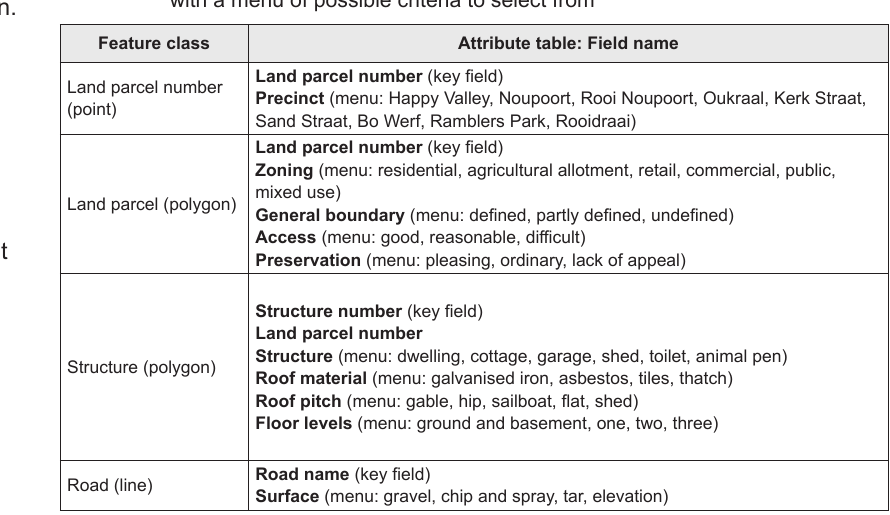
Attribute table: Each feature class is assigned a variety of attribute fields with a menu of possible criteria to select from Feature class Attribute table: Field name